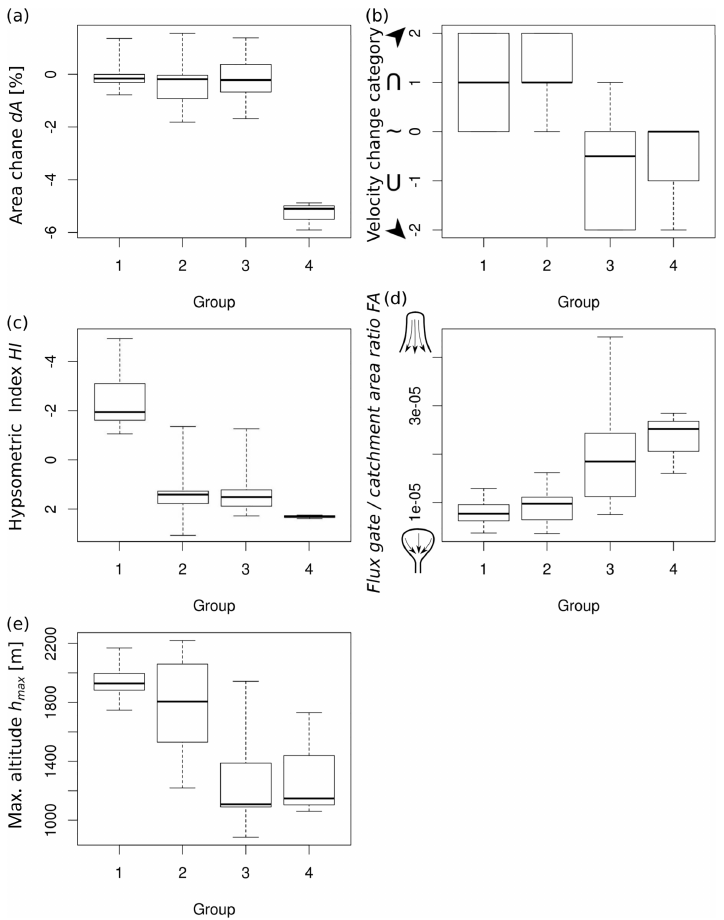
Figure 7. Box plots of cluster analysis input variables (sector West) for each group. Whiskers extend to the most extreme data points. (b) The symbols used for the velocity change categories (see Table 3) are the same as in Fig. 3. (d) The pictograms illustrate the catchment shape (see Sect.